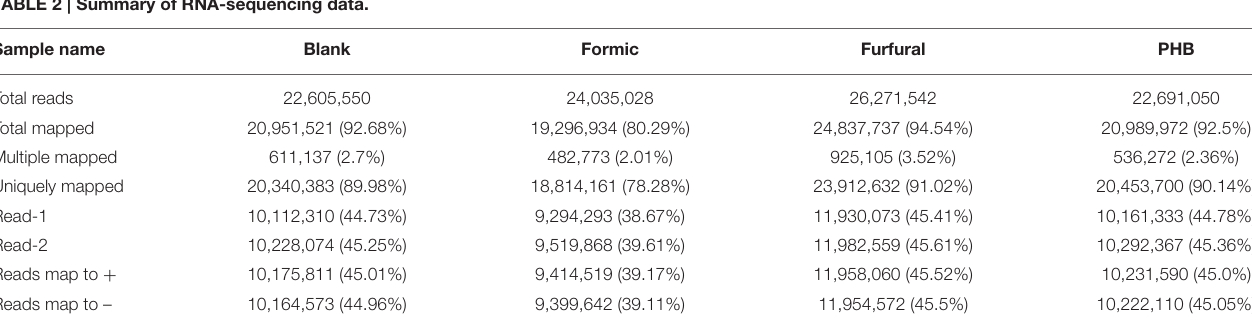
TABLE 2 | Summary of RNA-sequencing